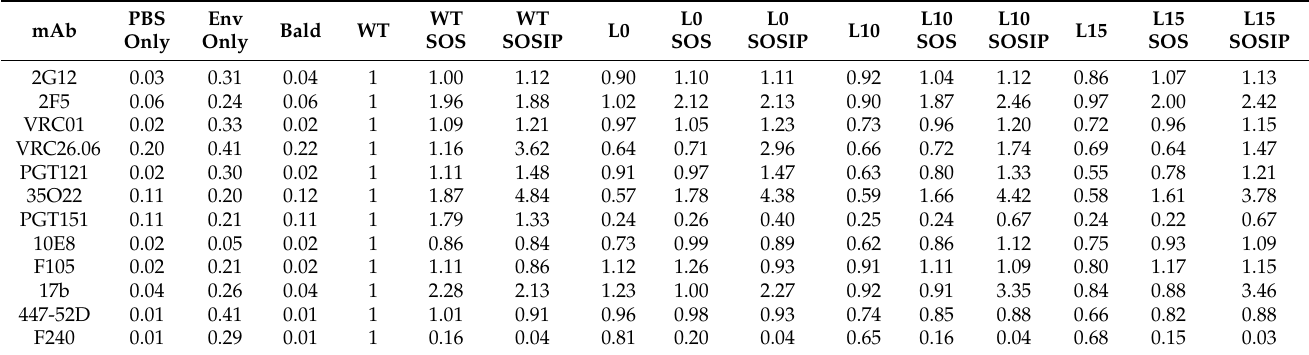
Table 1. Fold-change in mAb binding to mVLP-associated linker-stabilized